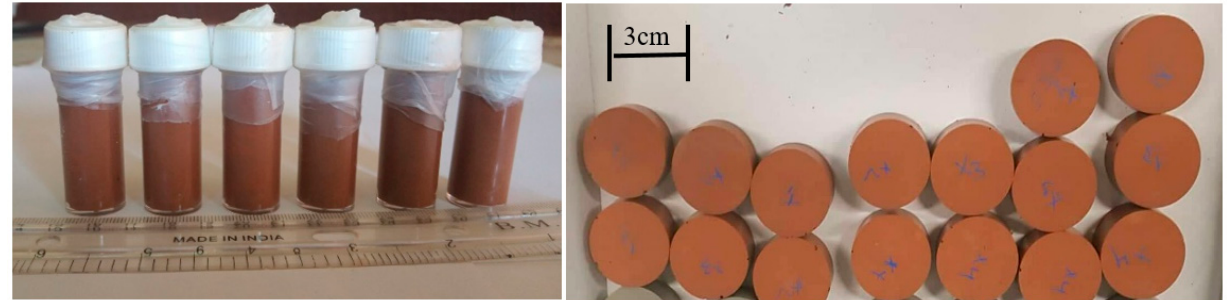
Figure 1. Geopolymer composite samples prepared for compressive ( left ) and Brazilian (diametral tensile) strength ( right ) tests.